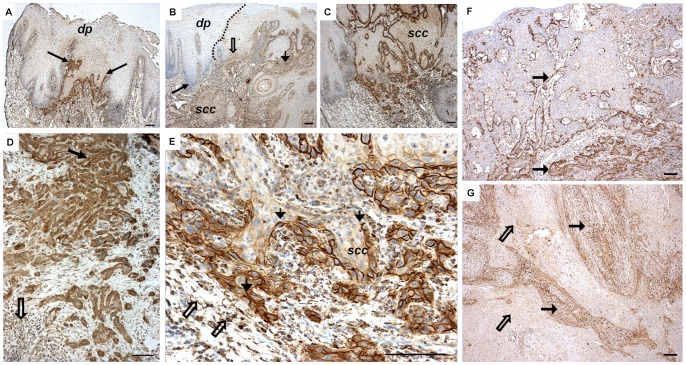
Cathepsin K immunostaining in invasive tongue cancer tissues and dysplastic oral epithelium.Cathepsin K in OTSCC tumors is localized in a few areas of dysplastic epithelium (dp) surrounding the cancer tissue (SCC) (A–B). A no staining area within a tumor slide with a score of (0) is shown by the first arrow (B). Other arrows, from left to right, show weak epithelial staining (+) and moderate stromal staining (++) (B). Cathepsin K shows a membranous, defined staining pattern in invading OTSCC carcinoma cells (C). The top arrow indicates an area with strong (+++) epithelial diffuse staining and moderate (++) stromal staining and the arrow below indicates stromal staining at the invasive front (D). At the invasive front, carcinoma cells show a cytoplasmic diffuse staining pattern. Big arrows indicate strong (+++) epithelial membranous staining. Empty arrows highlight individual cells in the stroma with moderate staining (++) (E). Arrows indicate different intensities of cathepsin K staining in superficial and invasive areas of tumor from weak (+) to moderate (++), illustrating the expression gradient observed in the samples (F). Example of strong stromal staining (full arrows) (+++) when epithelial staining is only moderate or weak (empty arrows) (G). Scale bars 200 µm.